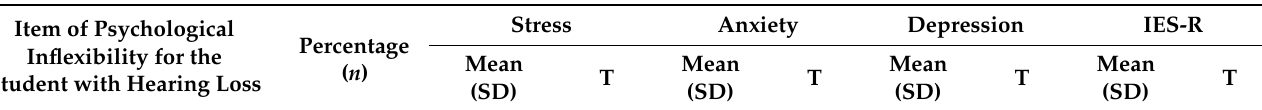
Table A1. The relation between psychological inflexibility and the psychological impact as well as mental health status for students with hearing loss ( n =